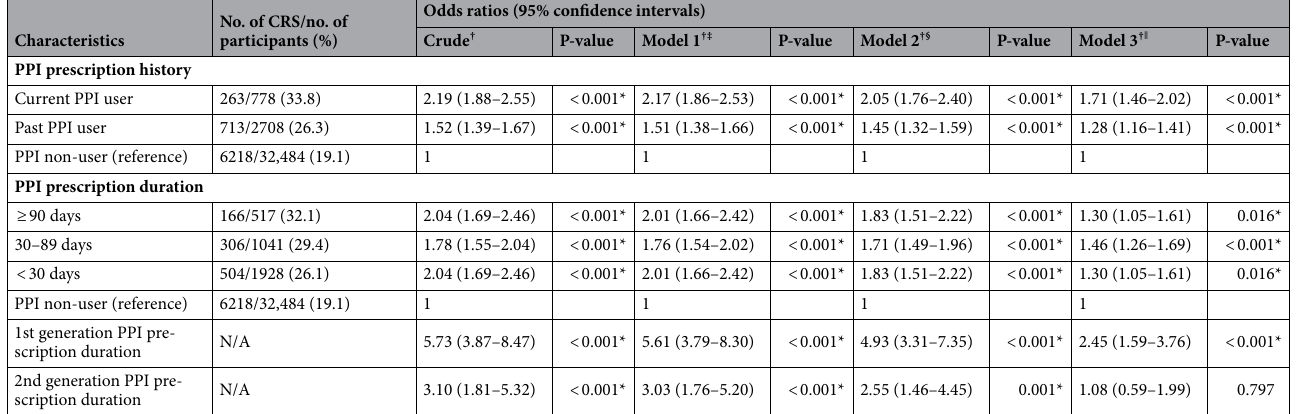
Table 2. Odd ratios (95% confidence interval) of CRS according to PPI prescription history/PPI prescription duration/each generation PPI prescription duration. CCI Charlson comorbidity index, COPD chronic obstructive pulmonary disease, CRS chronic rhinosinusitis, DBP diastolic blood pressure, GERD gastro- esophageal reflux disease, NSAID non-steroidal anti-inflammatory drug, PPI proton pump inhibitor, SBP systolic blood pressure. *Conditional logistic regression model, Significance at P < 0.05. † Models stratified by age, sex, income, and residence region. ‡ Model 1 was adjusted for total cholesterol, SBP, DBP, and fasting blood glucose. § Model 2 was adjusted for all variables in model 1 plus obesity, smoking, alcohol consumption, CCI score, asthma, and COPD. ‖ Model 3 was adjusted for all variables in model 2 plus the number of GERD treatments, steroid/ NSAID/ H2 blocker prescription